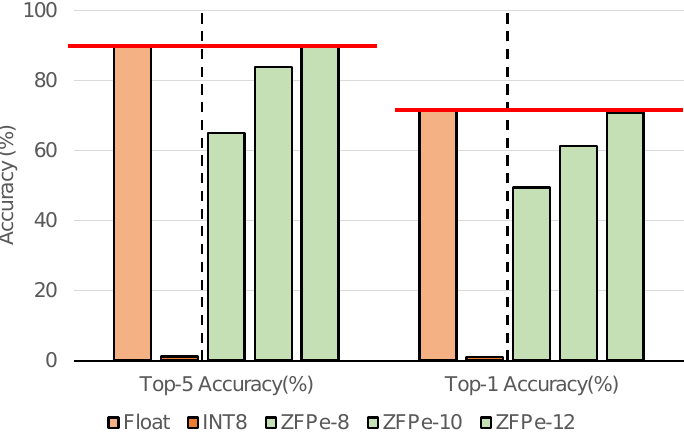
Figure 9. Top-5 and top-1 accuracy on MobileNet V2.